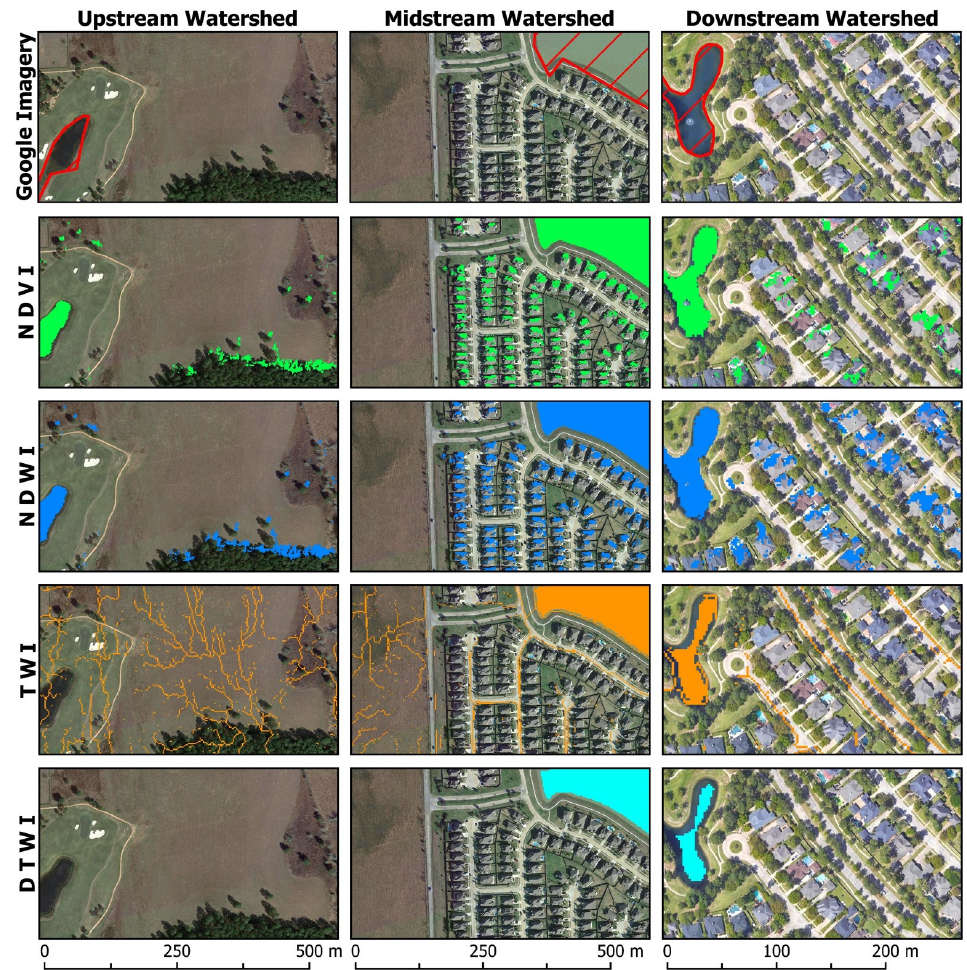
Figure 6. The mistakenly classified pixels of the four indices in the upstream (natural/agricultural area), the midstream (mixed agriculture-residential area), and the downstream (residential area) watersheds.